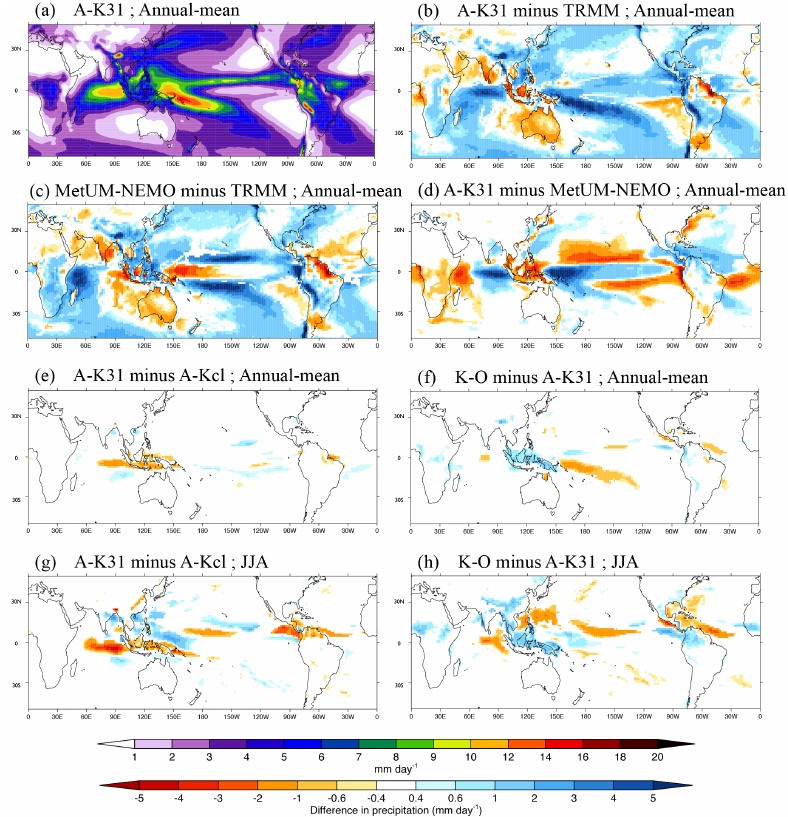
Figure 5. (a) Annual-mean precipitation from A-K31. (b and c) show the annual-mean bias of A-K31 and MetUM-NEMO against TRMM satellite observations. (d) Change of annual-mean precipitation between A-K31 and MetUM-NEMO. Impact of introducing interannual variability in SST ( e, g ; A-K31 minus A-Kcl) and having air–sea interactions ( f, h ; K-O minus A-K31) on annual-mean and JJA (June-July- August) precipitation, respectively. Differences are only shown where they are significant at the 95%